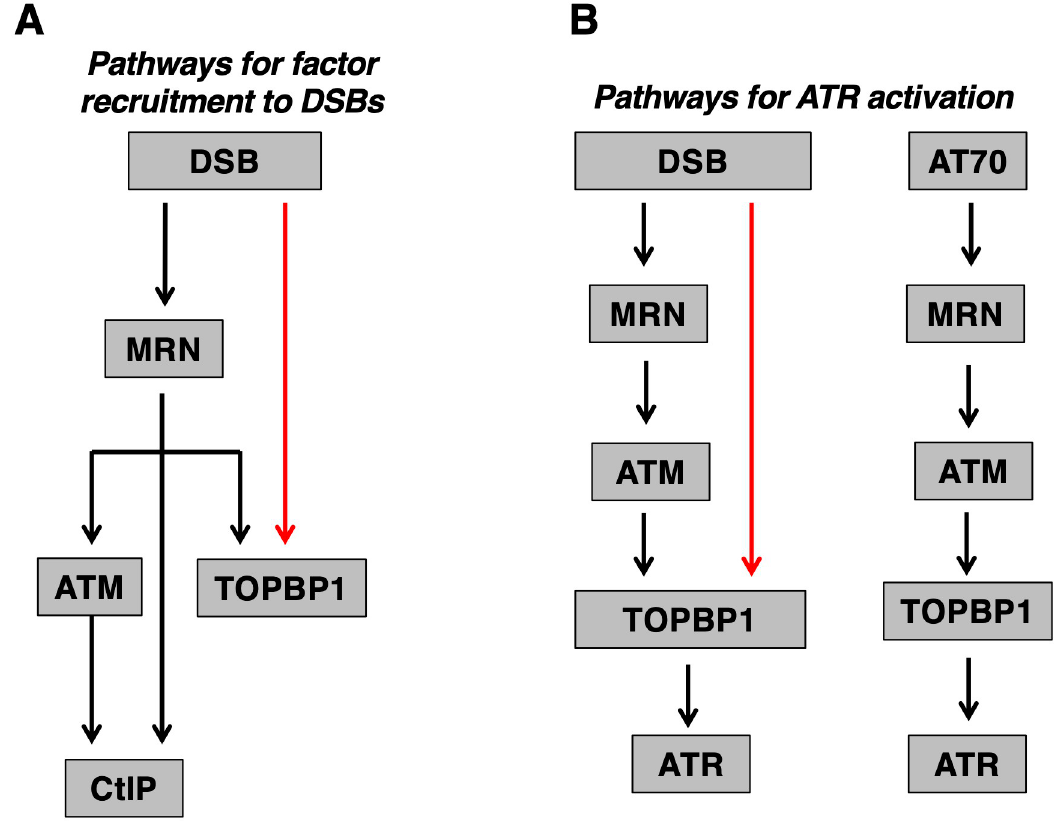
Fig 8. Multiple pathways for TOPBP1 recruitment and ATR activation by DSBs in Xenopus . A. Please see text for details. B. Please see text for